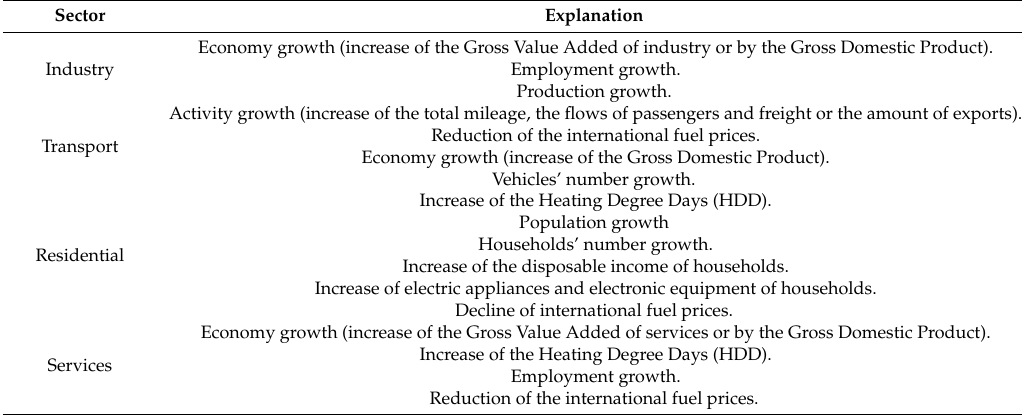
Table 3. More recurrent explanations delivered by Member States overall to justify stable or growing Final Energy Consumptions by end-use